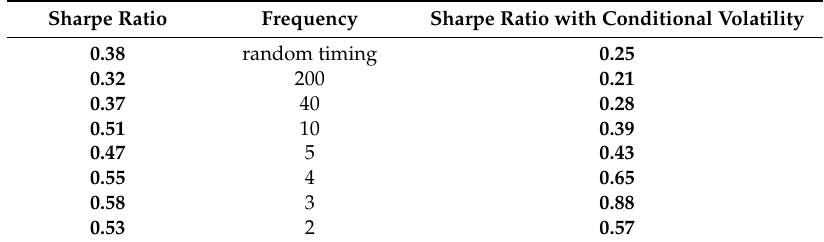
Table 5. Rolling window of 200 trading days, Sharpe ratios, data frequencies, and Sharpe ratios with conditional volatilities (bold denotes significance).